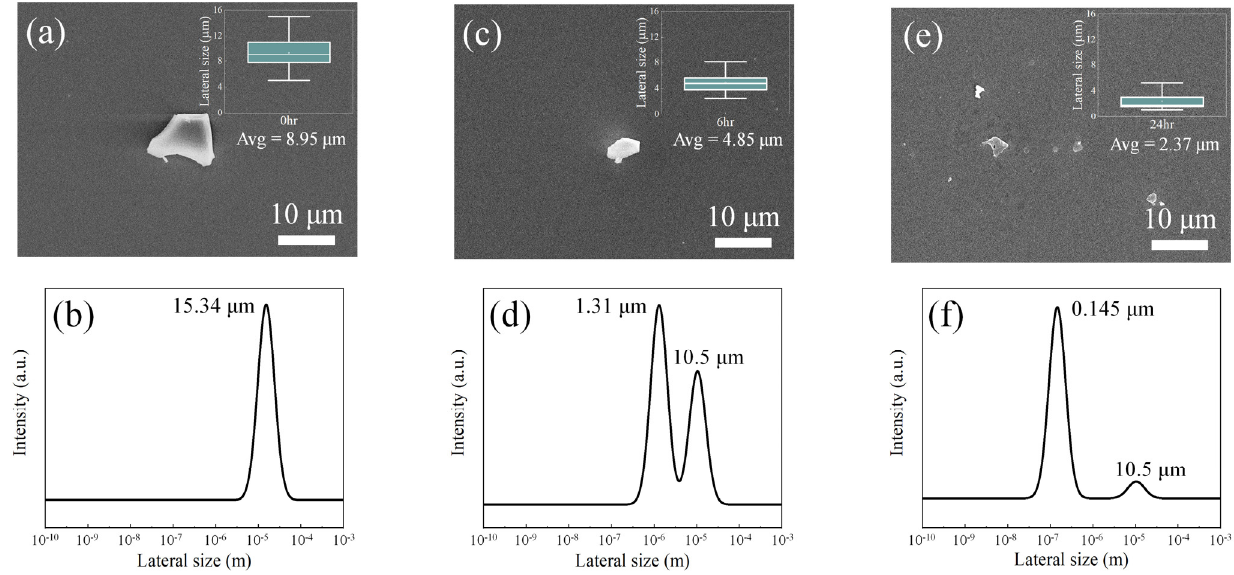
Figure 3. Representative scanning electron microscope (SEM) images of the ( a ) LGO, ( c ) MGO, and ( e ) SGO sheets. Inset data; box plots of the lateral size of the LGO, MGO, and SGO sheets. Dynamic light scattering (DLS) analysis of the lateral size distribution of the ( b ) LGO, ( d ) MGO, and ( f ) SGO sheets.